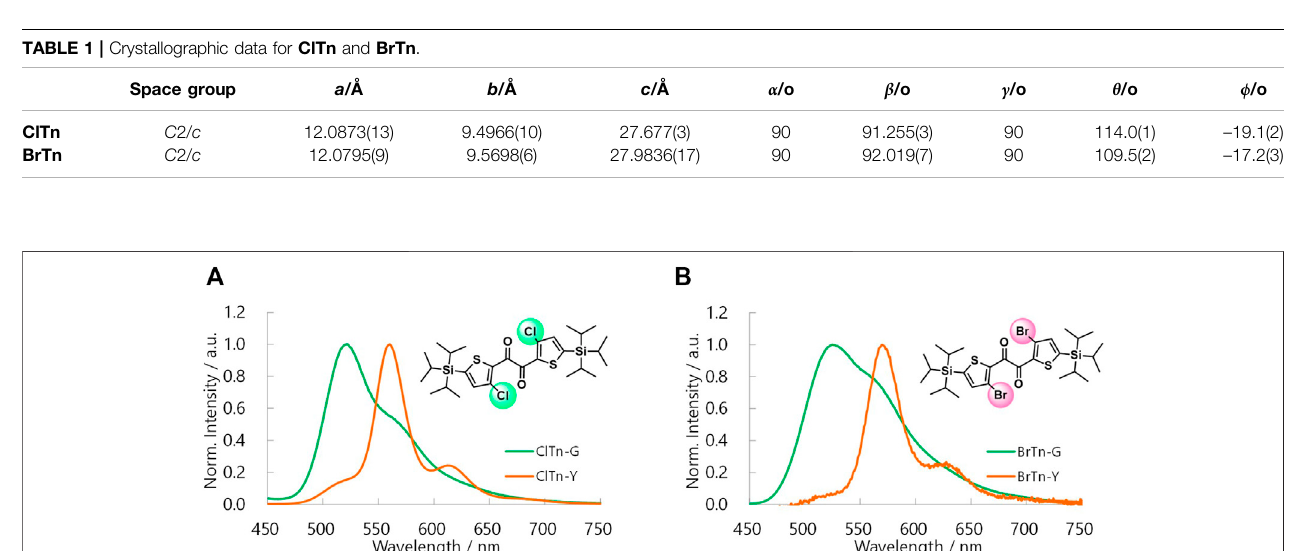
(cid:2) [ Φ ClTn-Y ] and α BrTn-G ]/[ Φ ClTn-G ], G p of p of respectively, and summed to construct the Φ p -weighted PL spectrum of ClTn-Y .